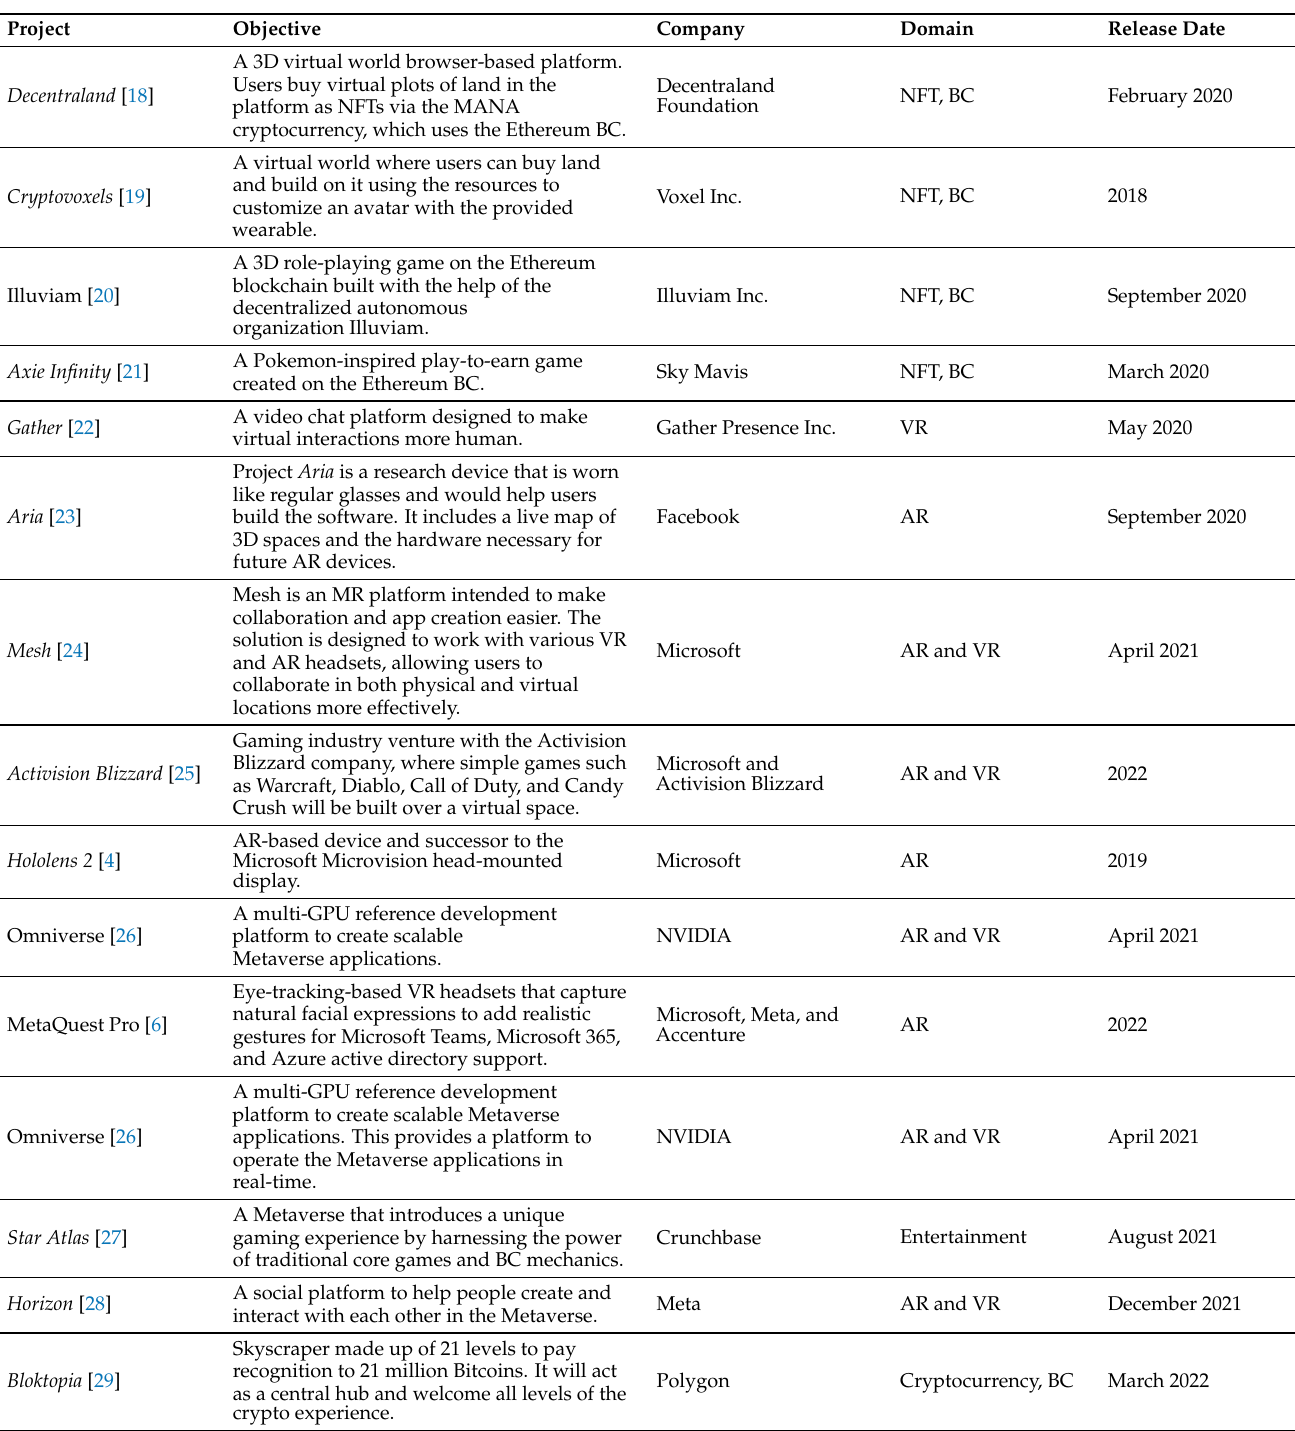
Table 2. Future Internet: key industry projects in Metaverse and assistive